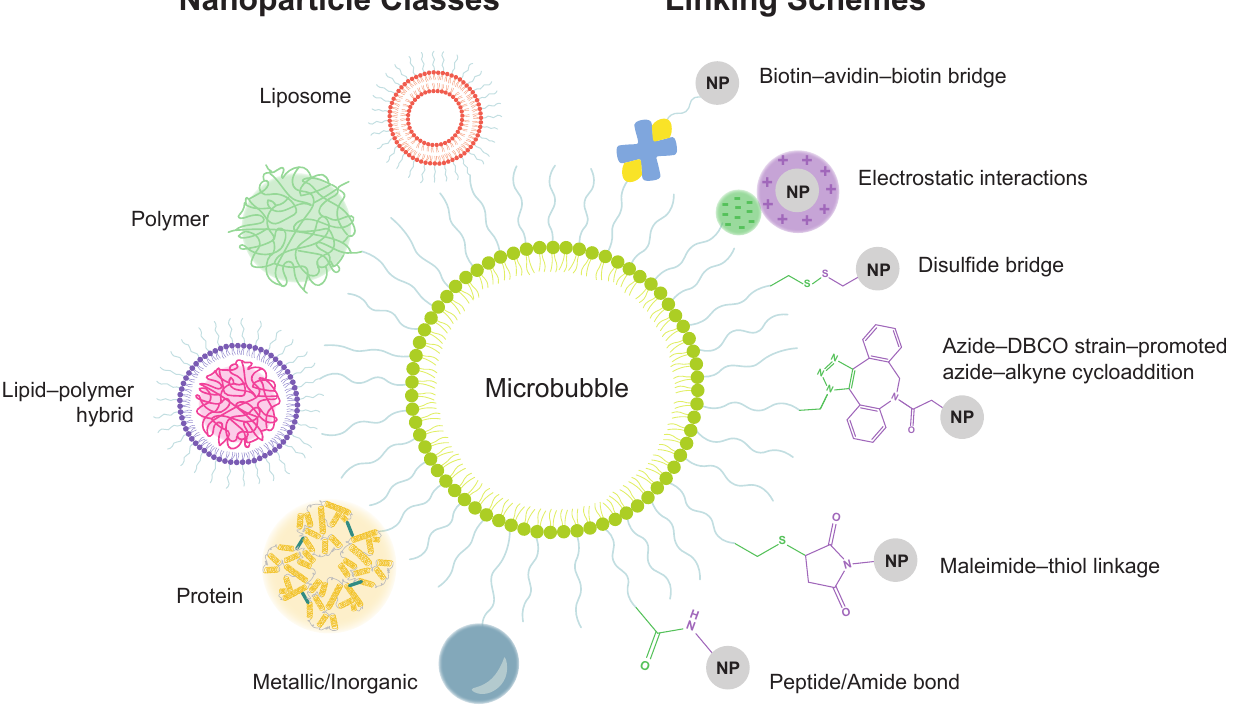
Figure 1. Microbubble–nanoparticle complex designs for ultrasound-controlled cargo